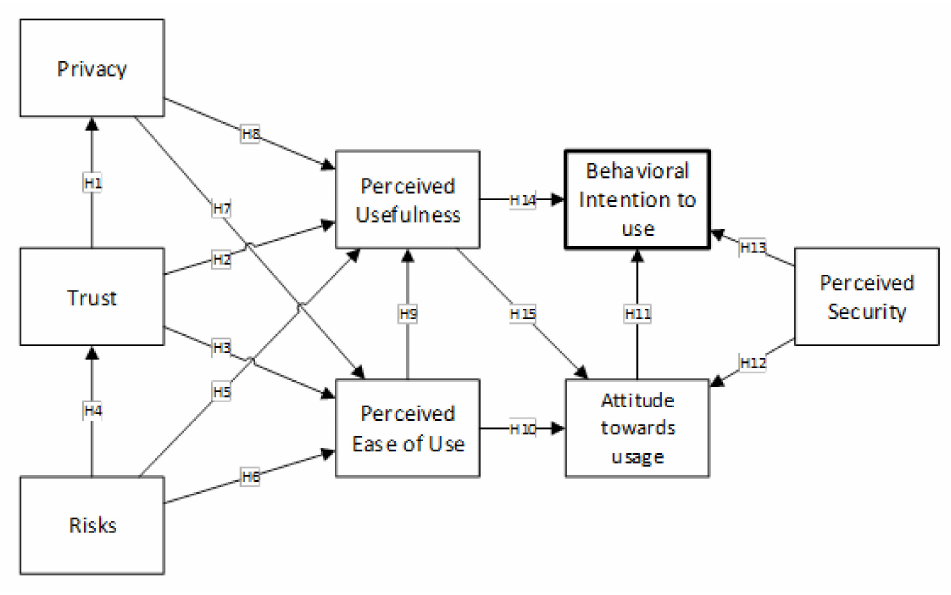
Figure 2. Proposed